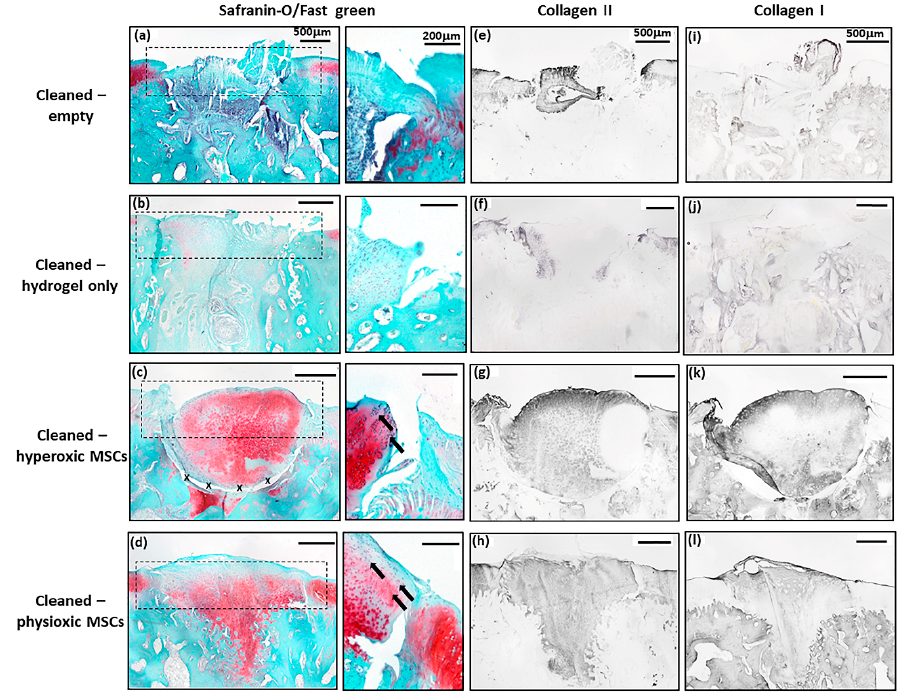
Figure 9. Representative images of ( a – d ) Safranin-O / Fast green, ( e – h ) collagen II and ( i – l ) collagen I staining for ( a , e , i ) empty defect, ( b , f , j ) hydrogel only, ( c , g , k ) hyperoxia and ( d . h , l ) physioxia treated focal early OA defects at 12 weeks post treatment. Box dotted line represents cartilage region evaluated for Sellers score and cross (x) signifies artefacts in the section. Arrows depict chondrocyte/ chondrocytic columns in the cartilage layer.